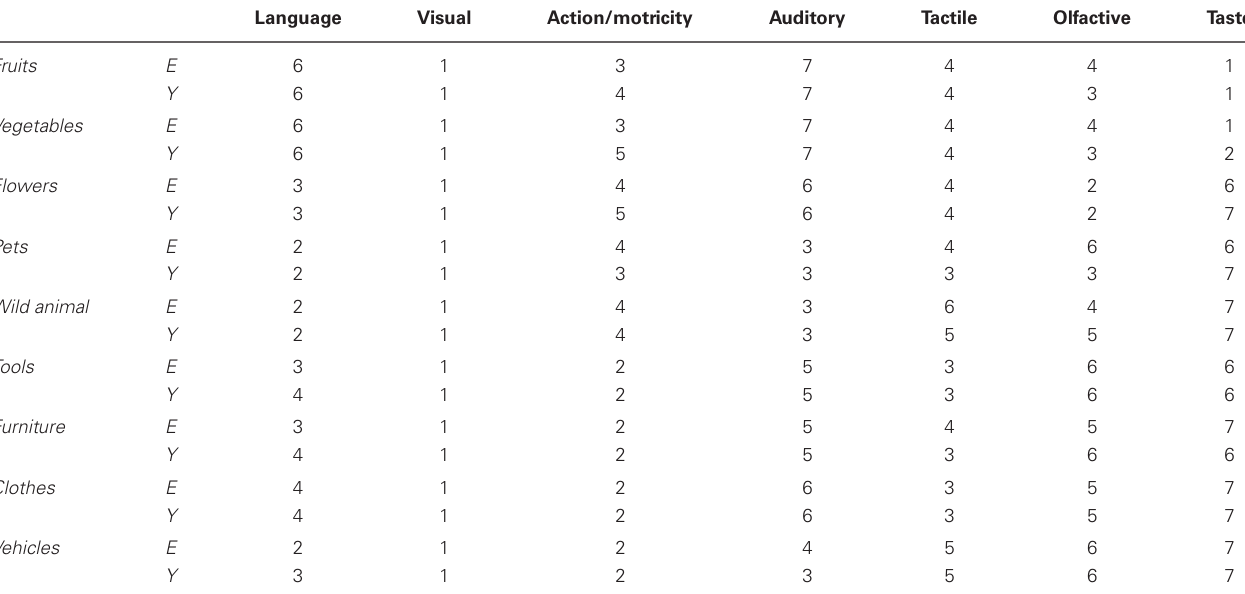
Table 4 | Rank order of the judgments of relevance of the various sources of knowledge for the specific semantic categories of animals, plant life and artifacts in Young (Y) and Elderly (E)